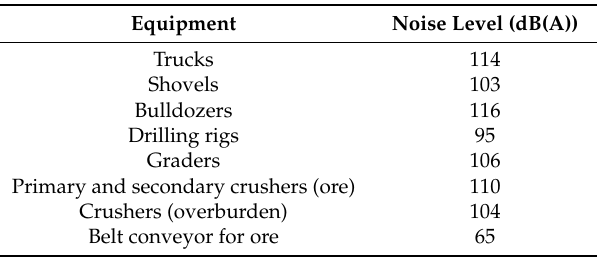
Table 3. Noise levels of mining, auxiliary, and other